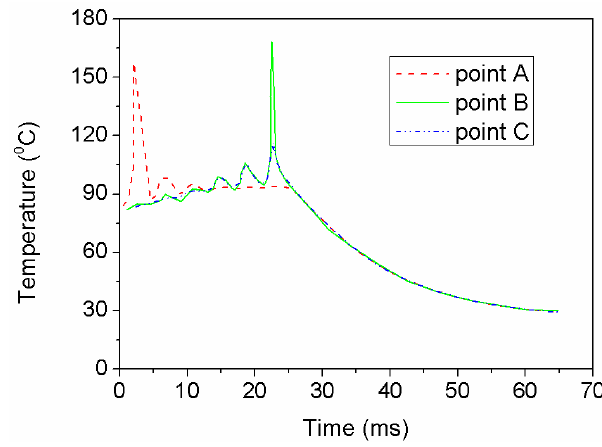
Figure 8. Temperature time history of identification of points.